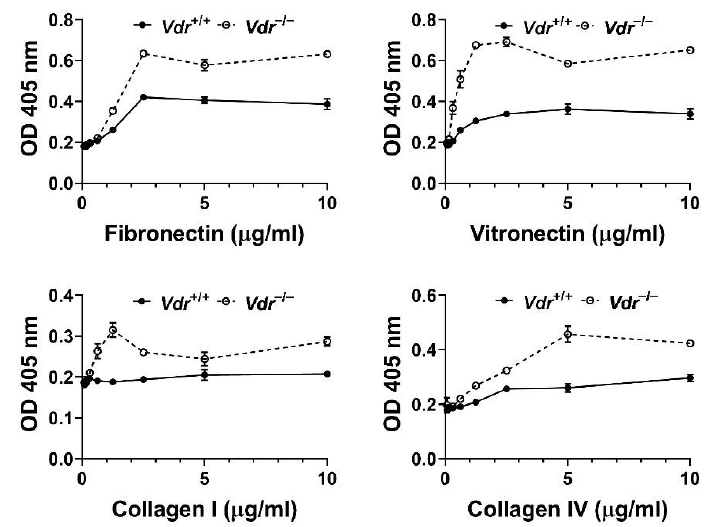
Figure 4. Vdr −/− retinal EC were more adherent to extracellular matrix proteins. Adhesion of retinal EC to fibronectin, vitronectin, collagen I, and collagen IV was analyzed as described in Methods. OD; optical density. These experiments were repeated with two different isolations with similar results.